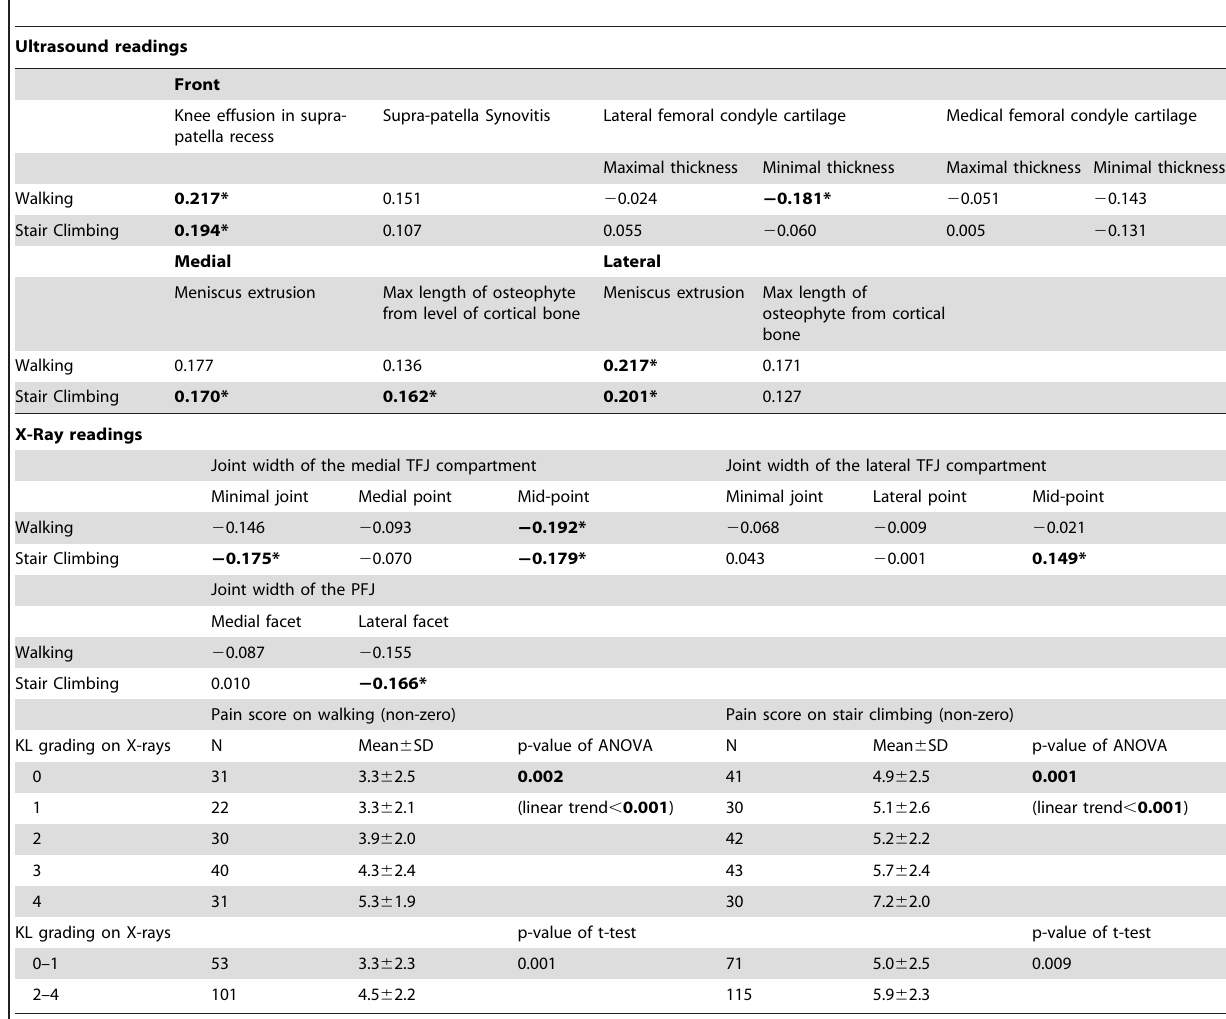
Table 2. Association among pain score (non-zero) on Walking and Stair Climbing, Ultrasound and X-Ray readings.